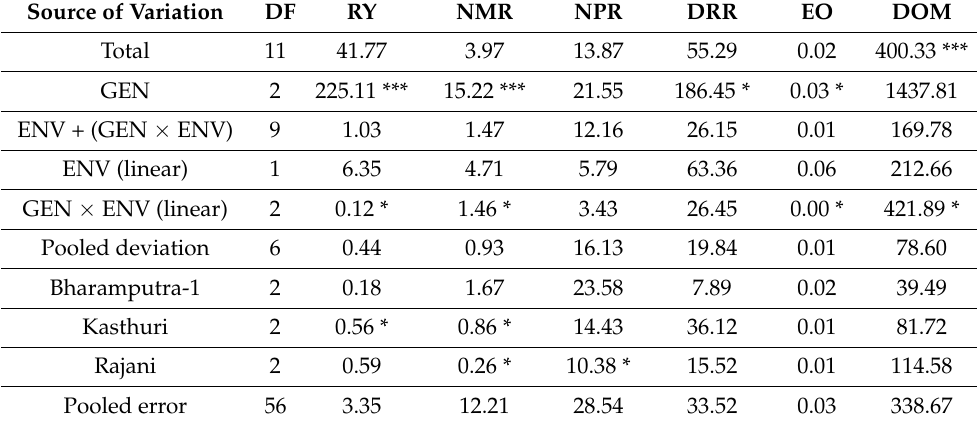
Table 4. Analysis of variance (ANOVA) through the regression method for the six traits of the three selected genotypes in MLT.